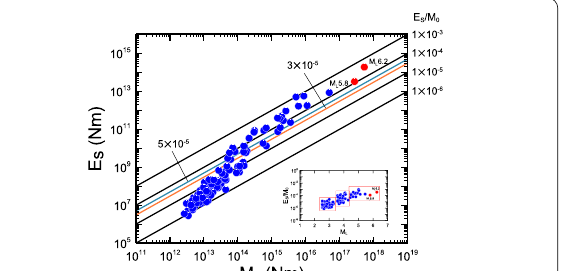
Fig. 5 The E S –M 0 plot. E S increases with increasing M 0 . E S / M 0 5 10 − 5 is from Kanamori (1977) for large earthquakes, and = × E S /M 0 3 10 − 5 is estimated by Ide and Beroza (2001) for a wide = × M 0 range. The insert illustrates the relation between E S /M 0 and M L . On average, E S /M 0 5.3 10 − 6 , 6.3 10 − 5 , and 2.7 10 − 4 for = × × × 2.5 < M L < 3.5, 3.5 < M L < 4.5, and M L > 4.5, respectively. This reveals that the Orowan stress drops are approximately 3, 40, and 160 bar